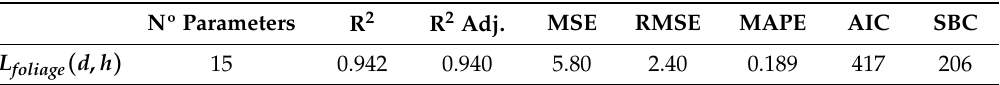
Table 5. Evaluation parameters of the regularised optimisation carried out for 15 parameters. Nº Parameters R 2 R 2 Adj. MSE